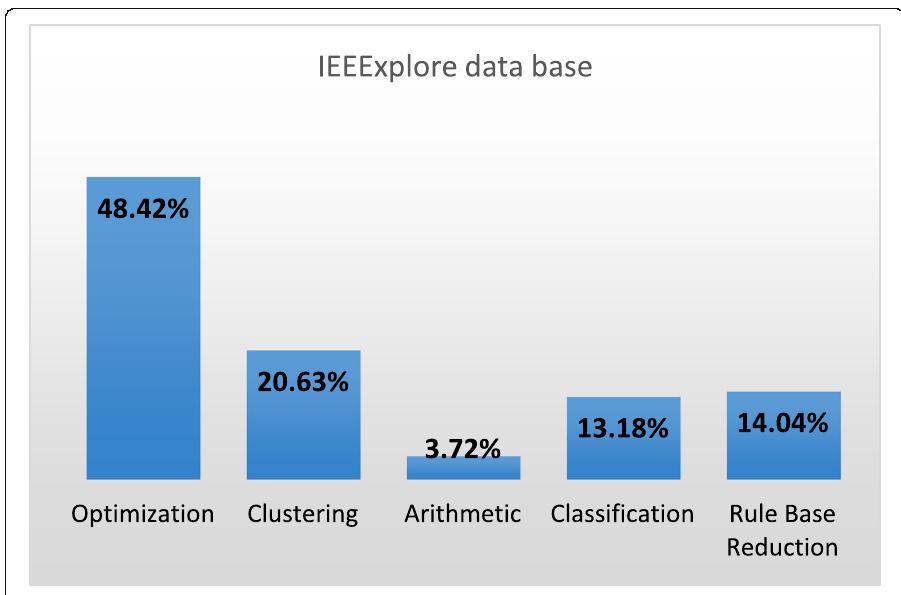
Fig. 11 IEEExplore fuzzy tool